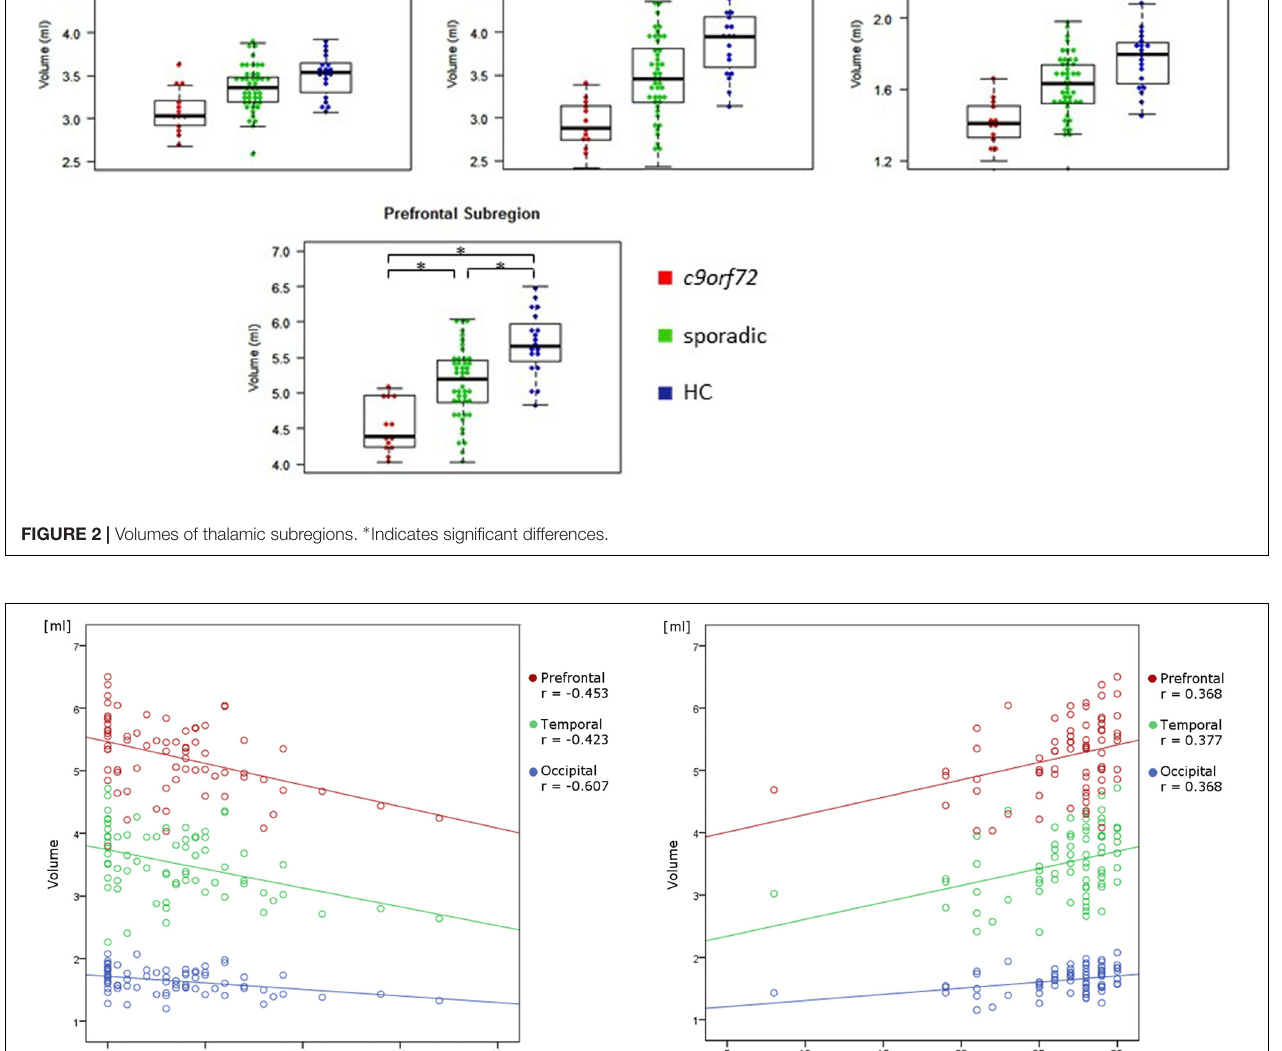
Frontiers in Aging Neuroscience |